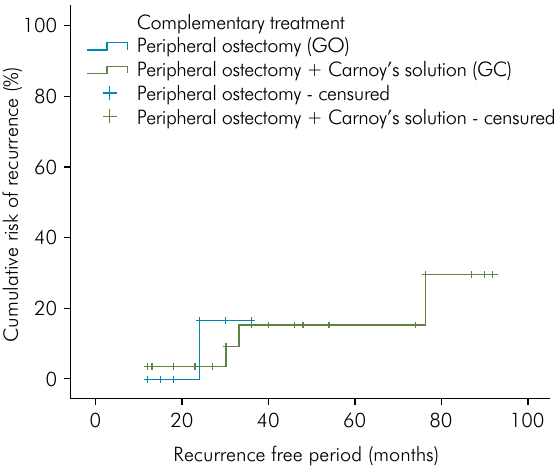
Figure 6. The cumulative risk of recurrence by the Kaplan-Meier analysis according to the complementary treatments.